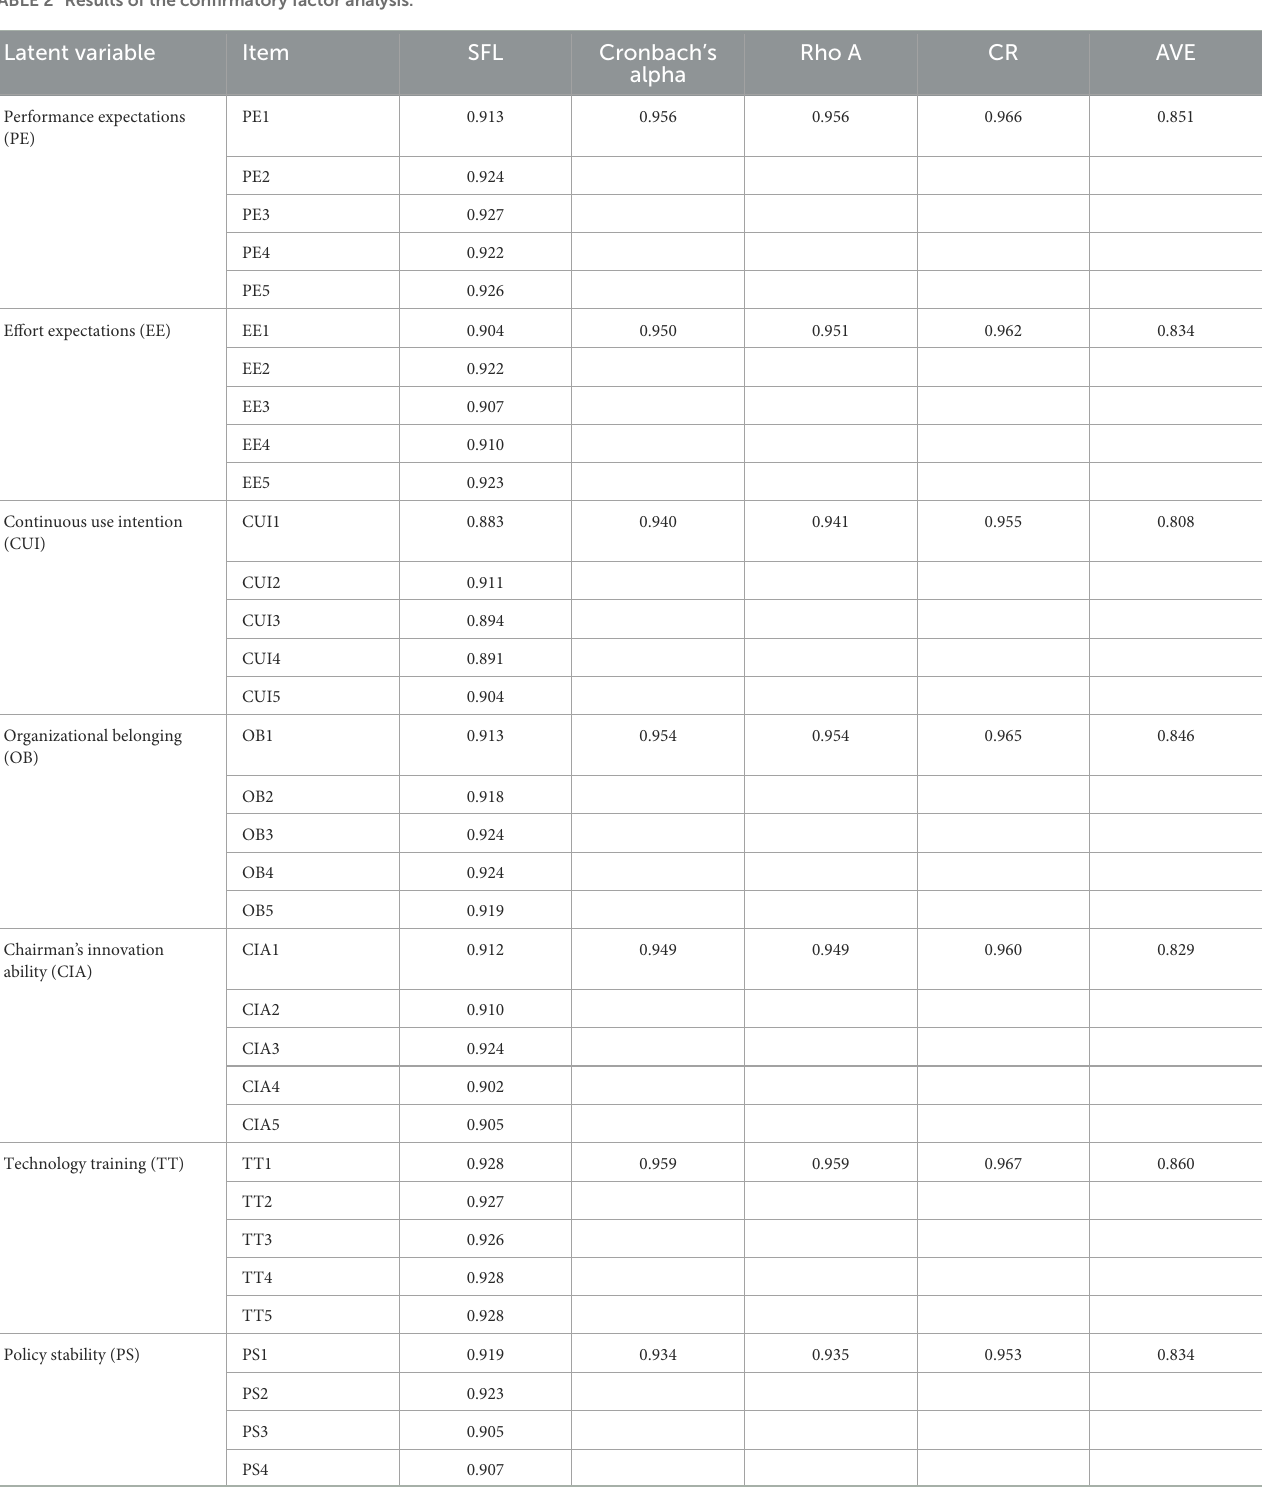
TABLE 2 Results of the confirmatory factor